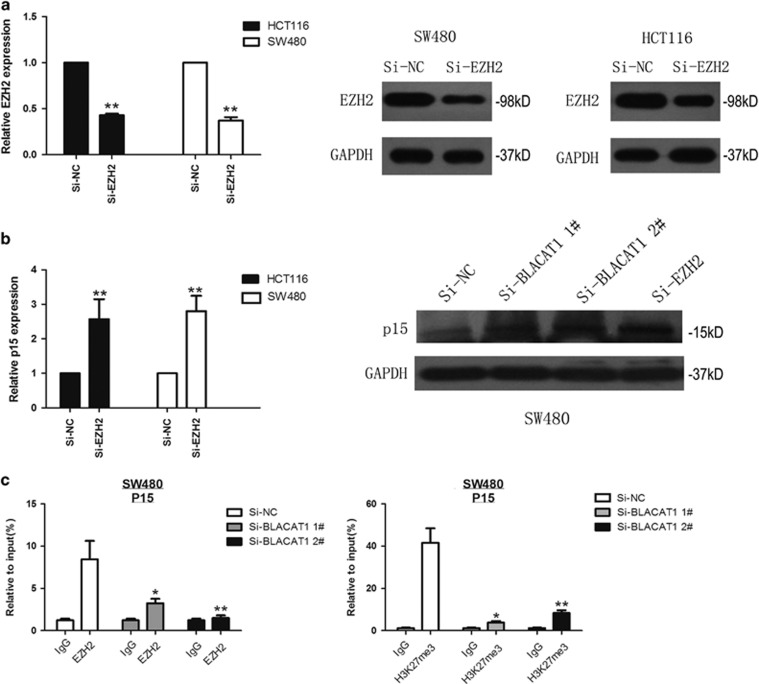
BLACAT1 is required to target PRC2 occupancy and activity to epigenetically regulate the expression of CKIs, thus regulating gastric cancer cell cycle and proliferation. (a) The expression of EZH2 was determined after knockdown of EZH2 by qRT-PCR and western blot assays. (b) The expression of p15 was determined after knockdown of EZH2 by qRT-PCR and western blot assays, and relative expression was determined in SW480 cells transfected with si-BLACAT1 (si-BLACAT1 1# and si-BLACAT1 2#) by western blot assays. (c) ChIP-qPCR of H3K27me3 and EZH2 of the promoter region of p15 locus after siRNA treatment targeting si-NC or si-BLACAT1 in SW480 cells, Antibody enrichment was quantified relative to the amount of input DNA. Antibody directed against IgG was used as a negative control. **P<0.01